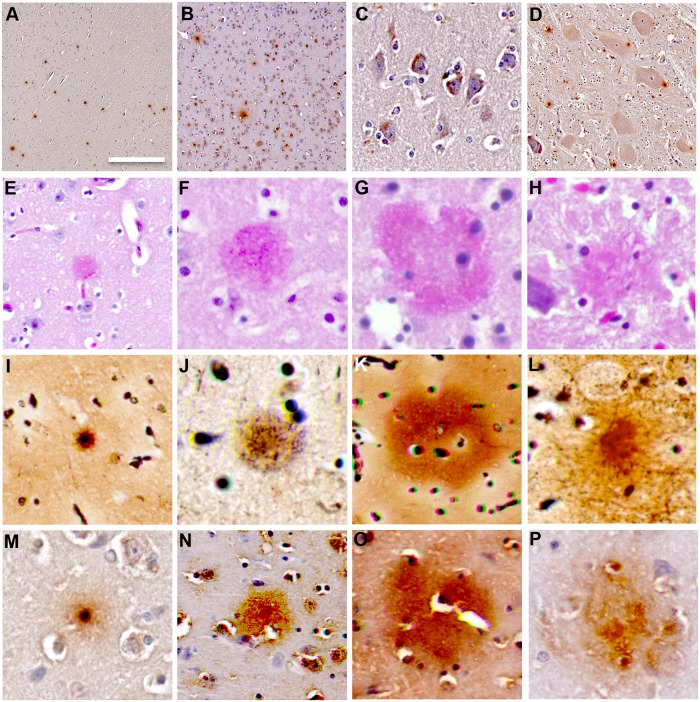
Aβ deposition in the cerbral cortex of stranded dolphins.(A) Anti-Aβ IHC demonstrates Aβ+ plaques in the cerebral cortex of stranded dolphins. (B) Intraneuronal Aβ+ accumulation was aslo observed throughout upper and lower cortical layers. (C) High-resolution digital patholgy scans of pyramidal neurons in the ACtx containing dense intracellalur Aβ+ inclusions. (D) Large and sparse Aβ+ plaques were observed in the Md of stranded dolphins. (E-P) Aβ+ plaques were different in morphology as observed by H&E staining (E-H), MB silver staining (I-L) and Aβ+ IHC (M-P). Aβ+ plaques ranged from small focal with compact cores (E, I, M), primative immature cotton wool-like (F, J, N), to large and diffuse (G, K, O) and ill-defined (H, L, P). Representative scale bar: 500 μm (A, B & D), 100 μm (C), 50 μm (E-P).